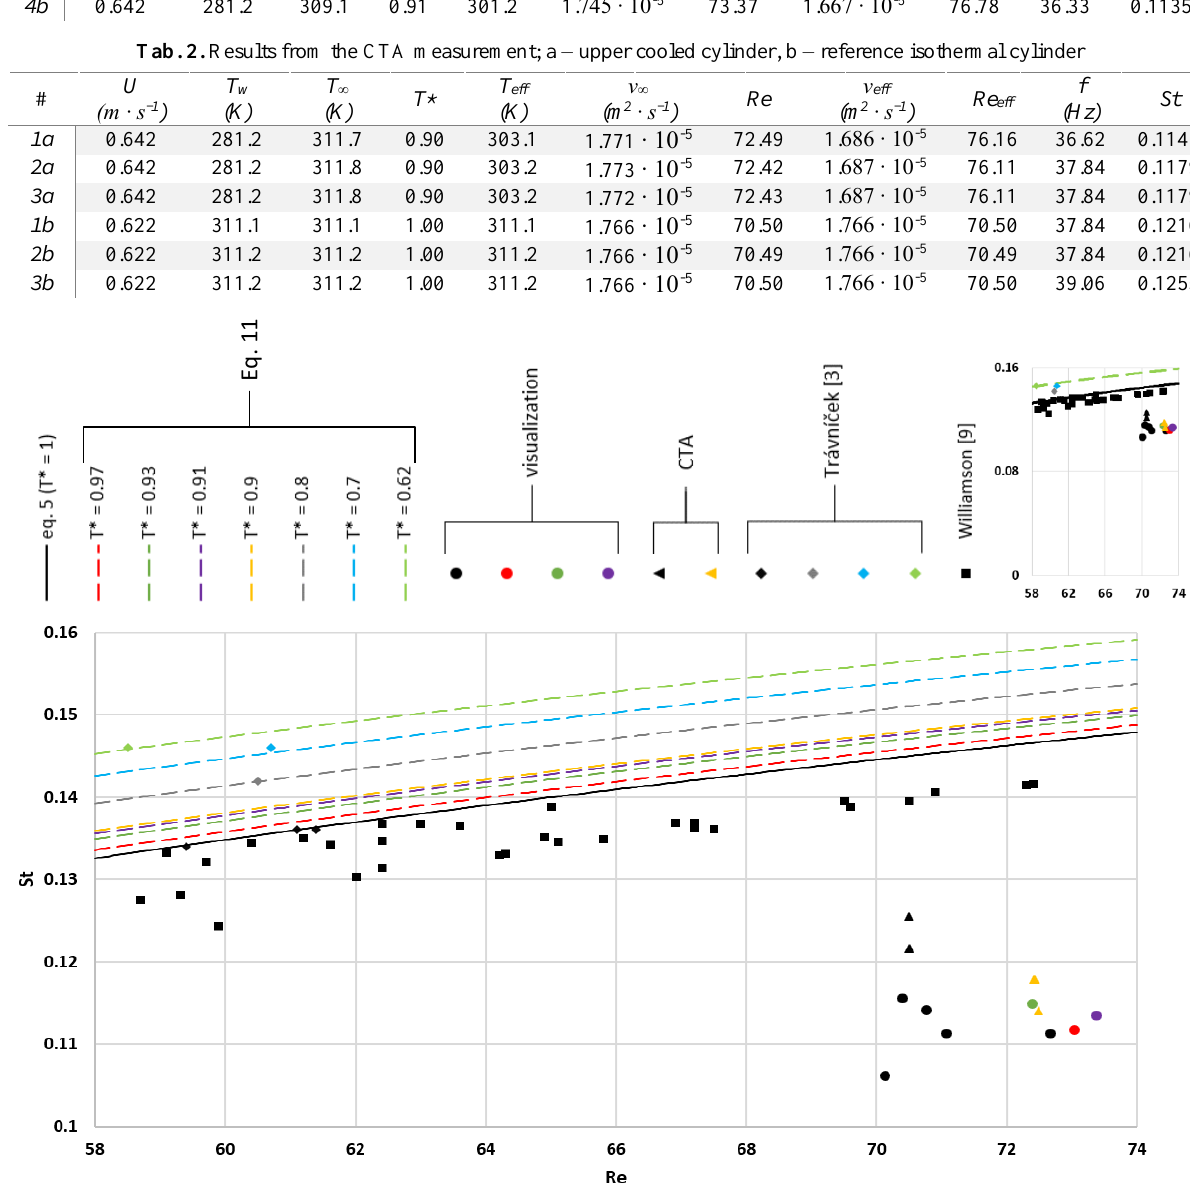
Fig. 8 Dependence of the Strouhal number St on the Reynolds number Re. Strouhal numbers that the theoretical values (curves)